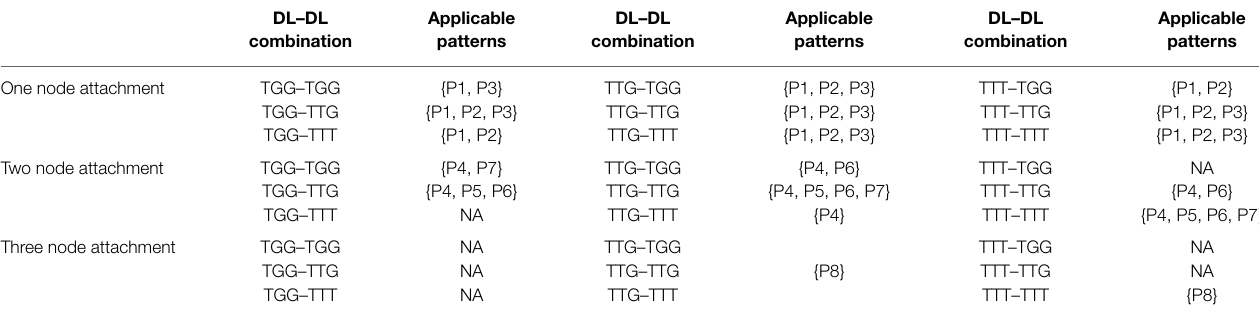
TABLE 3 | Applicable downlink to downlink attachments for a given candidate downlink, incoming downlink, and number of vertex overlaps